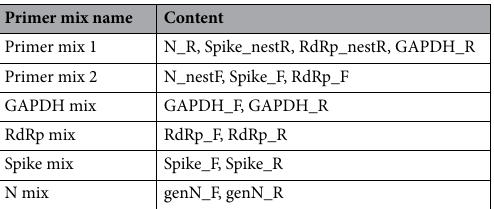
Table 2. Composition of the primer mixes used in this study. Each individual primer had a concentration of 10